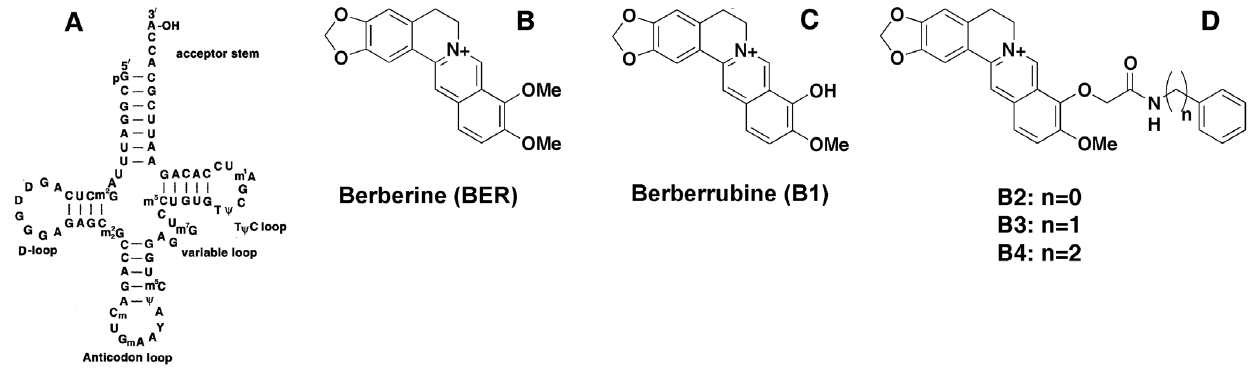
Figure 1. Chemical structures. (A) cloverleaf structure of tRNA, (B) berberine, (C) berberrubine and (D) analogs B2, B3, B4.